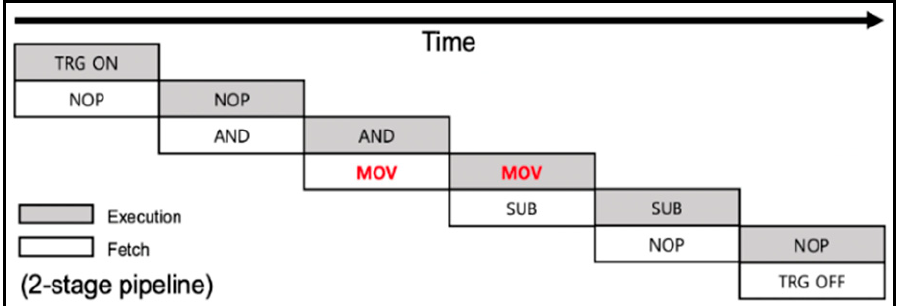
Figure 2. Single-level pipeline applied to the ATxmega128.